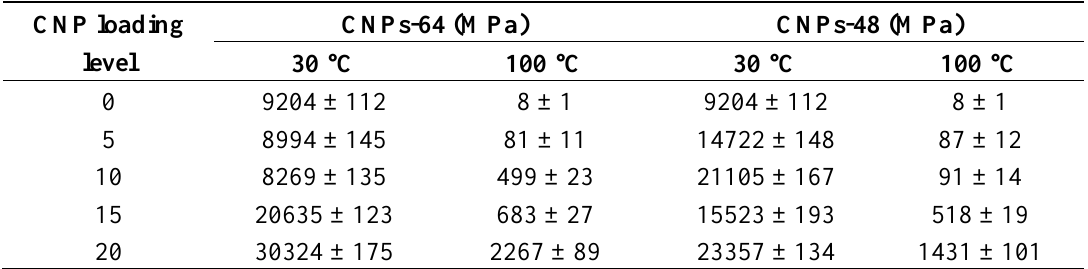
Table 1. Storage modulus (mean ± standard deviation) of CNP/PMMA composites at different CNP loadings.